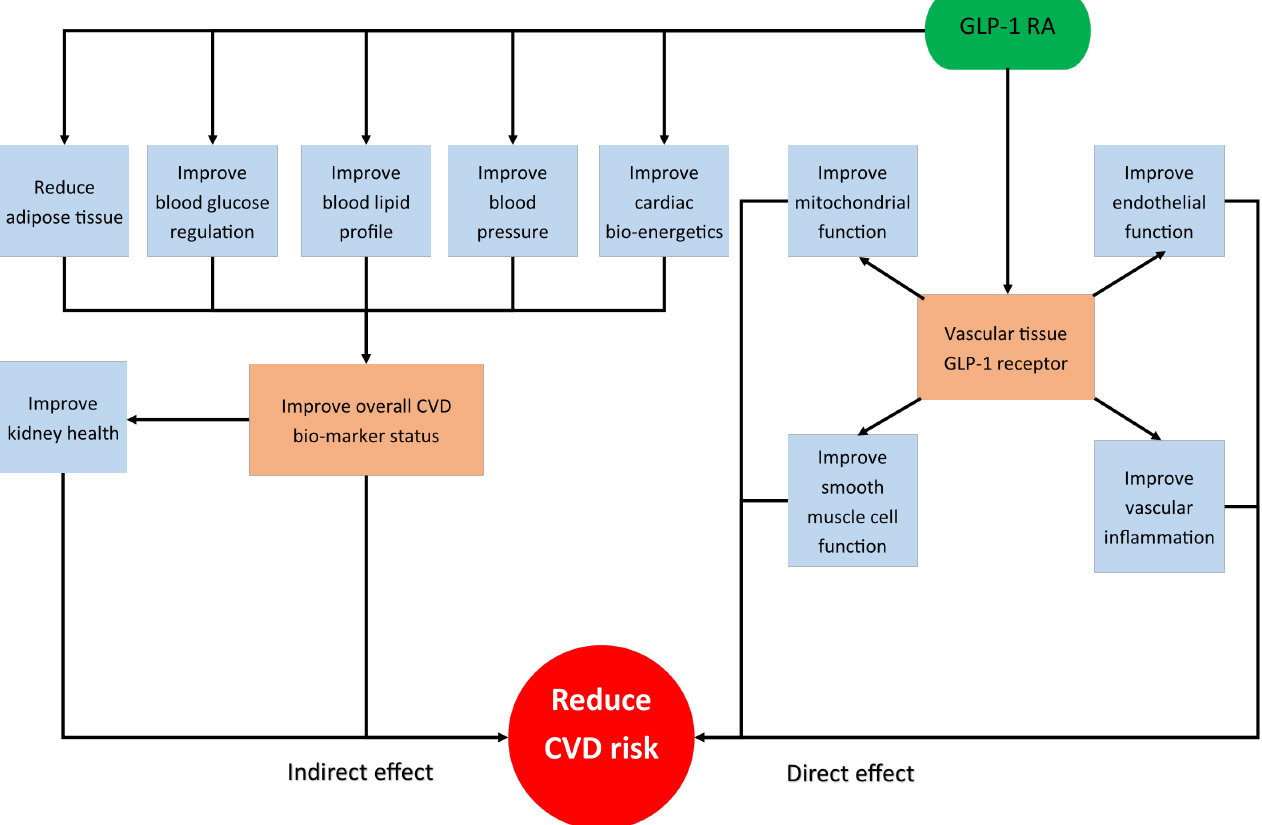
Figure 1. A schematic that outlines the direct and indirect actions of GLP-1 RAs in reducing CVD